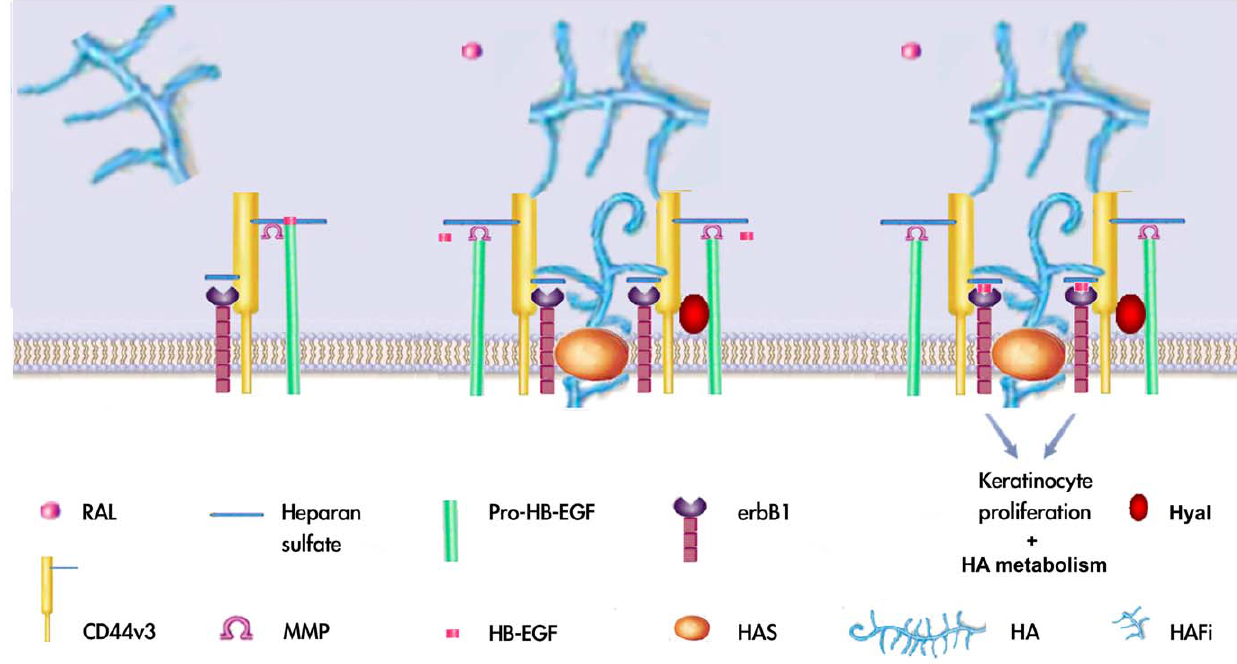
Figure 6. Hypothetical assembly of CD44v3/HB-EGF/erbB1/HAS/Hyal (hyalurosome) complex and the mechanism of RAL and HAFi- induced keratinocyte proliferation. Schematic representation of the assembly of the putative complex: HAFi mediates CD44v3 and heparan- sulfate-bound pro-HB-EGF aggregation, resulting in the recruitment and activation of an MMP/ADAM. RAL increases the endogenous HA production by induction of HAS which will contribute to the aggregation of CD44v3 and pro-HB-EGF and to the activation of MMP/ADAM. Pro-HB-EGF is cleaved by the MMP/ADAM and the resulting active moiety binds and activates erbB1, generating proliferation signals. Endogenous HA synthesis is controlled by HA-degrading enzyme hyaluronidase (Hyal).